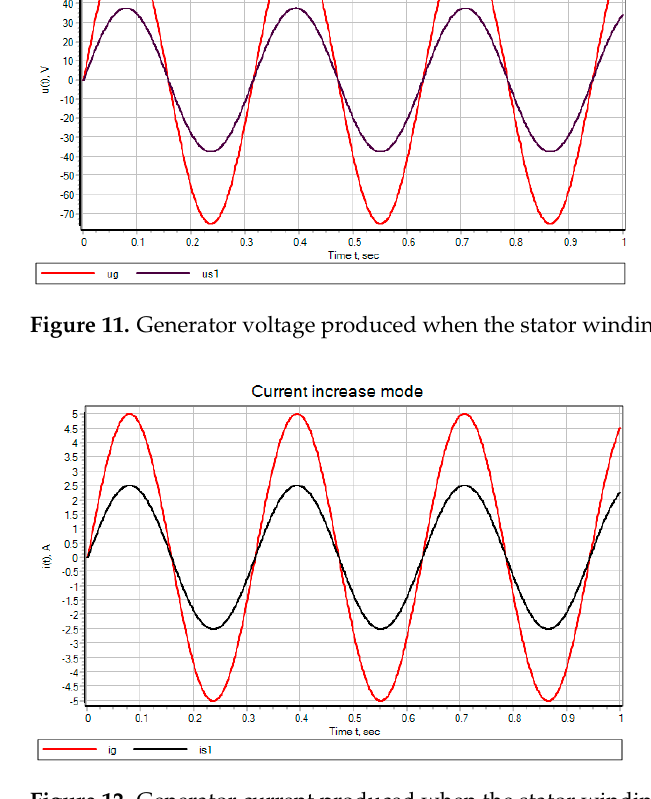
Figure 12. Generator current produced when the stator windings were connected in series.